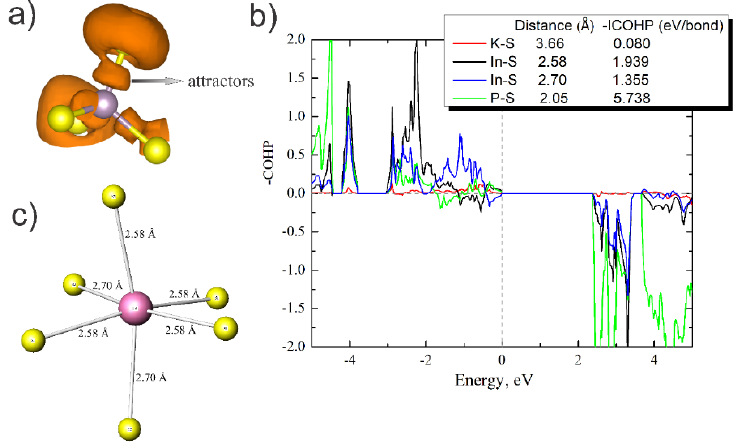
Figure 3. ( a ) 3D isosurfaces of the ELF for a [PS 4 ] tetrahedral within KInP 2 S 7 with η = 0.75, P: gray, S: yellow. ( b ) COHP analyses of selected interactions within KInP 2 S 7 . ( c ) The [InS 6 ] octahedron with bond distances labeled. P: gray, In: pink, S: yellow.